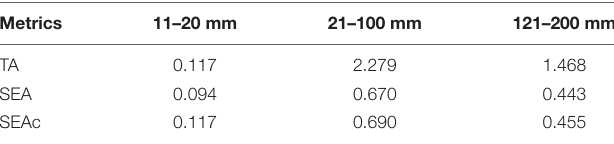
TABLE 1 | Metrics for estimating isotopic niche size in three Sepia esculenta groups.